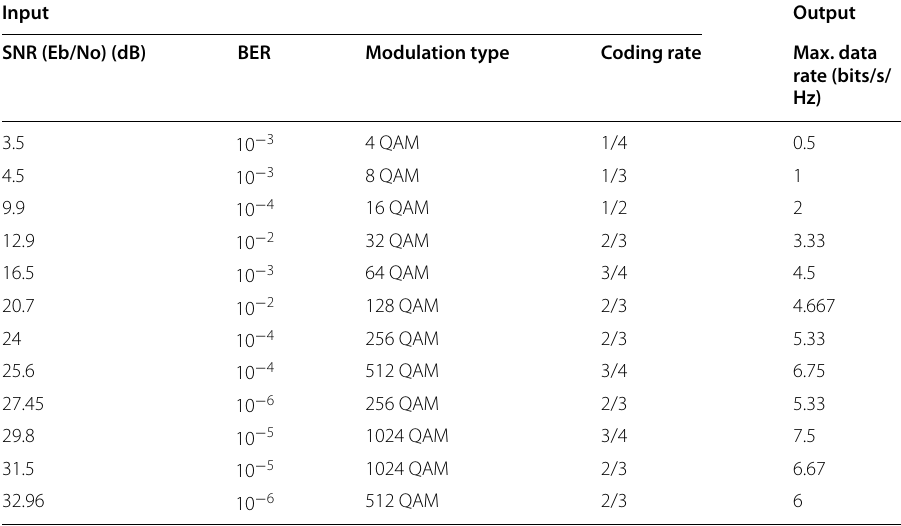
Table 3 Sample of I/O data pairs obtained from graph resulted from simulation Input Output SNR (Eb/No)